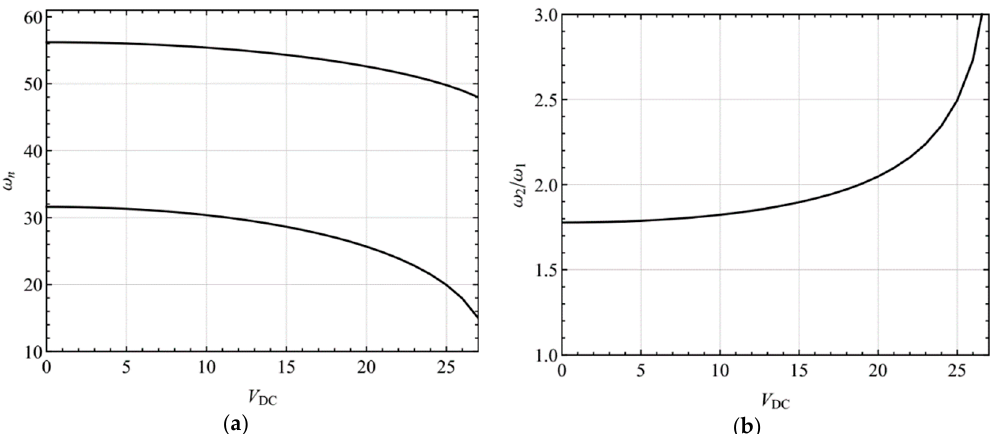
Figure 2. ( a ) Natural frequency variation against V DC ; ( b ) variation of the frequency ratio between the second and first natural frequencies with V DC . second and first natural frequencies with V DC